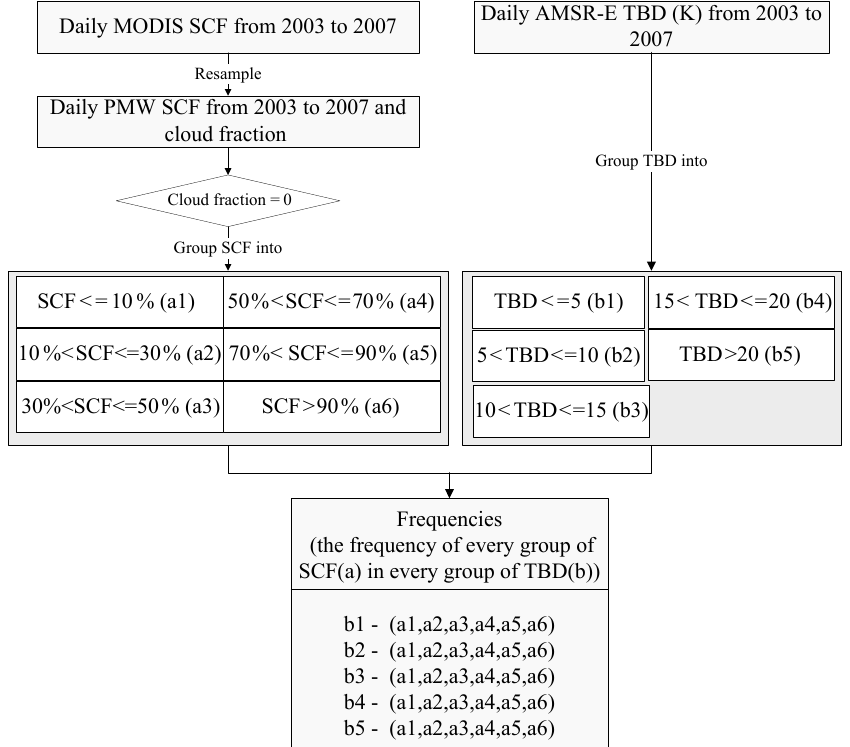
Figure 2. Flowchart for building the TBD–SCF table, which provides the relationship between snow cover fraction (SCF) and passive microwave brightness temperature difference (TBD). The SCF of the PMW grid was calculated based on the MOD10A and MYD10A products from 2003 to 2007, and TBD was computed using AMSR-E brightness temperature at 18 and 36GHz for horizontal polarization from 2003 to